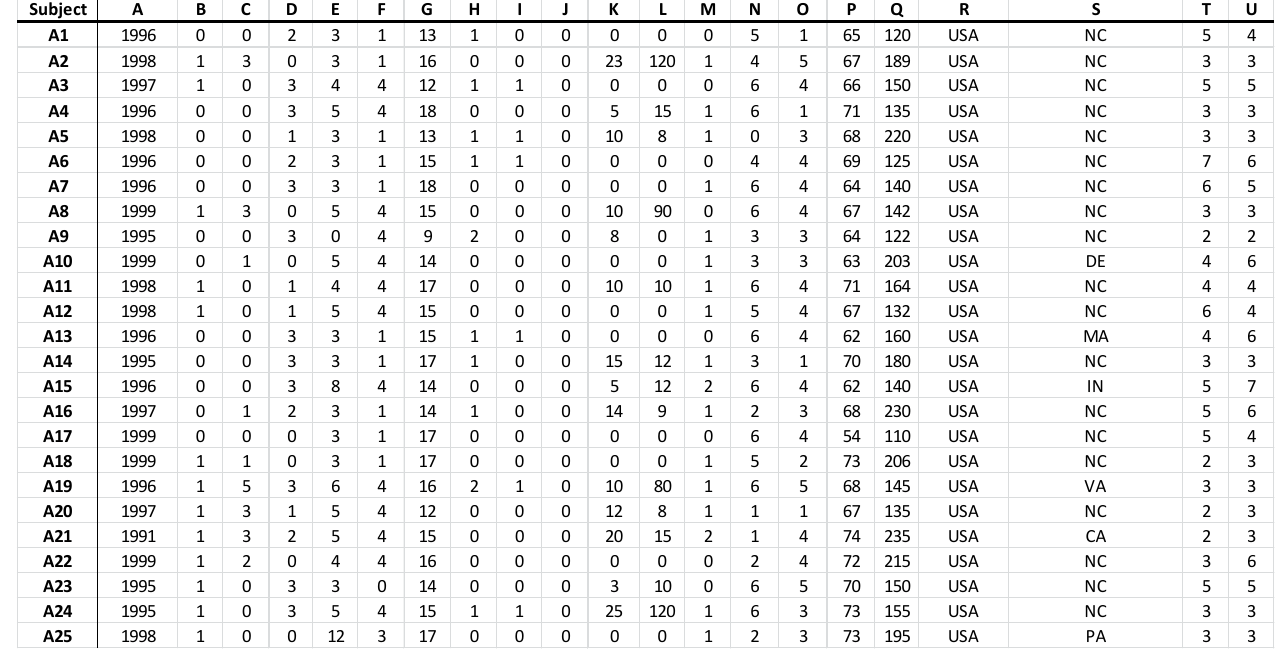
Figure A13. Individual Demographic Data—Session A.